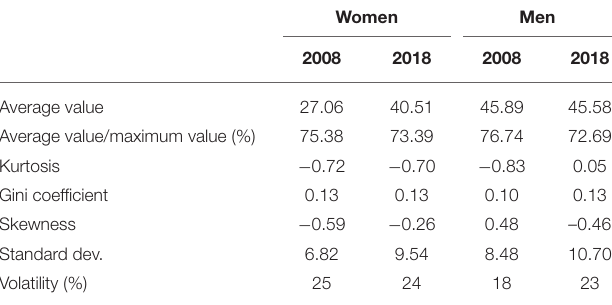
TABLE 8 | SP18—descriptive statistics for the years 2008 and